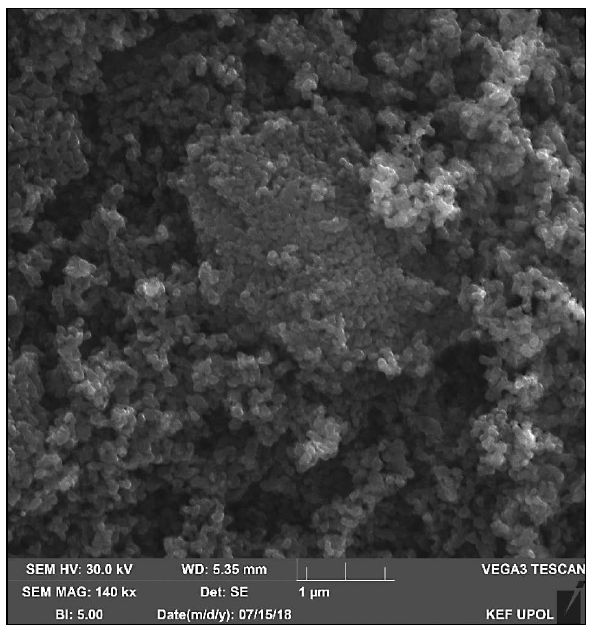
Figure 4. SEM images of samples T550H1 (left) and T550H12